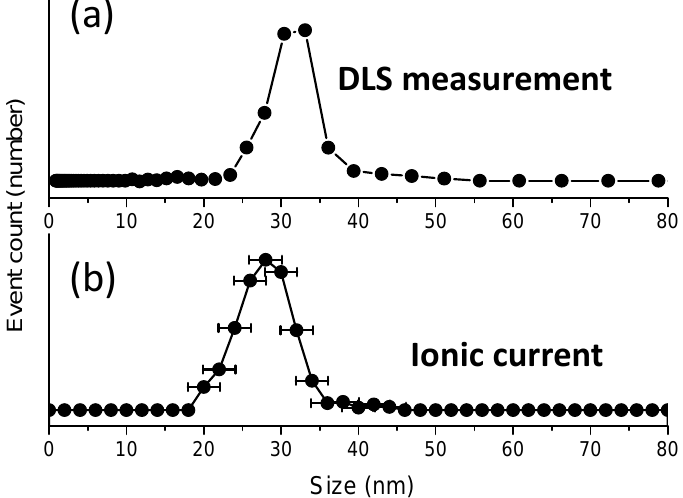
Figure 5. Size distribution of the magnetic nanoparticle obtained from ( a ) the dynamic light scattering (DLS) method and ( b ) the ionic current